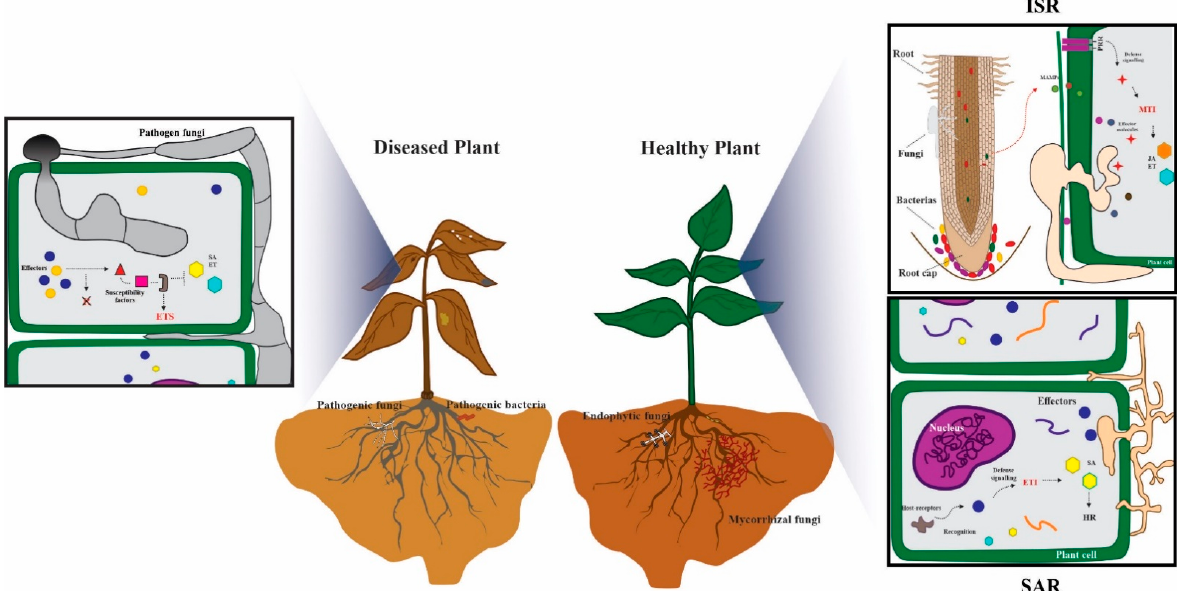
Figure 1. Effectors are major determinants of plant disease. Pathogens secrete effectors that can induce disease susceptibility through targeting host susceptibility factors and subverting the ETI defense response resulting in disease, ETS, ( left ). On the other hand, pathogens can also induce ETI and systemic acquired resistance (SAR) when hosts have the corresponding resistance proteins that recognize Avr effectors, producing the HR and stopping the progression of the pathogen ( right ).